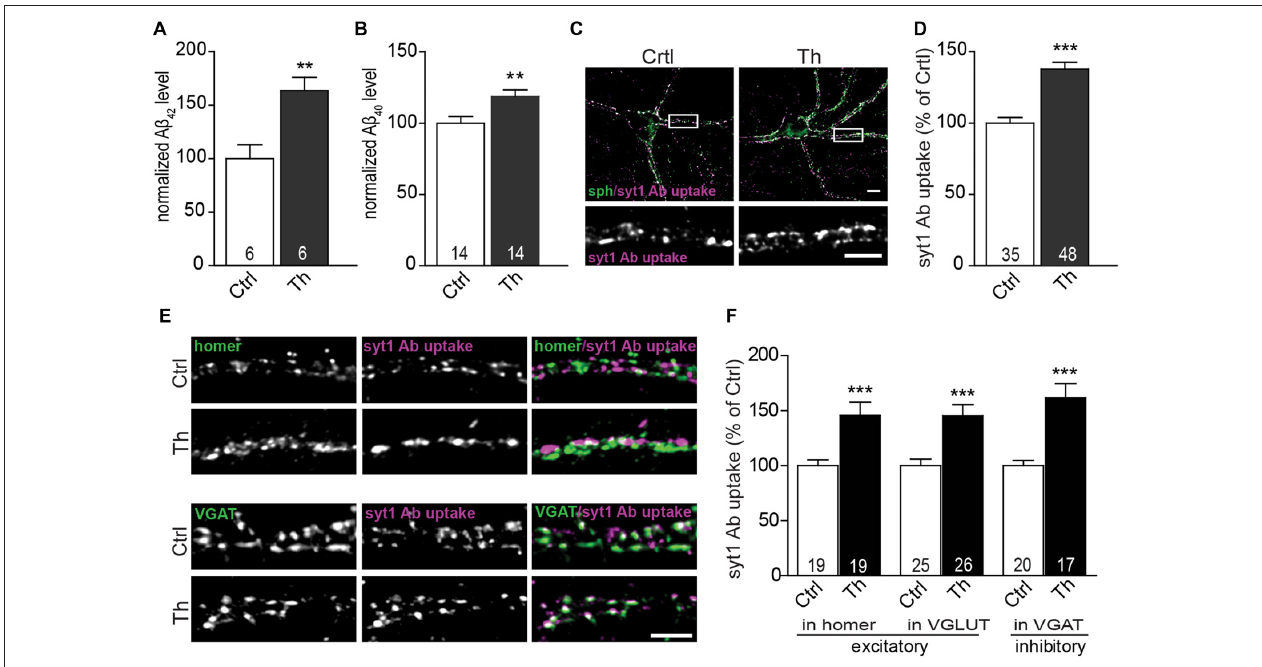
FIGURE 1 | Endogenous A β modulates presynaptic activity at excitatory and inhibitory synapses. (A,B) Quantification of A β x-42 (A) and A β x-40 (B) levels in the medium from vehicle- and Th-treated cortical cells using sandwich ELISA. Numbers within columns represent the number of individually treated and analyzed wells obtained from two (A) and three (B) independently prepared cell cultures. (C) Representative images of syt1 Ab uptake (magenta) from vehicle- and Th-treated cortical neurons. Synaptophysin (sph, green) was used as a synaptic marker. Regions showed in high magnification are boxed. (D) Quantification of normalized fluorescence intensity of network activity-driven syt1 Ab uptake in control and Th-treated neurons along proximal dendrites. (E) Representative images of syt1 Ab uptake, from cortical neurons incubated with Th or control solution, at excitatory (homer, green) and inhibitory (VGAT, green) terminals. (F) Statistical quantification of the intensity of syt1 Ab uptake in puncta positive for either excitatory (homer, VGLUT) or inhibitory (VGAT) synapses driven by the spontaneous network activity. Numbers within columns show the number of analyzed cells derived from five (D) and two (F) independent cultures. Values are expressed as the mean ± SEM. Effect of treatment was compared to untreated control by unpaired two-tailed Student t test ( A,B,D,F syt1 Ab uptake in VGLUT-positive and VGAT-positive) or Mann Whitney test ( F , syt1 Ab uptake in homer-positive puncta); ∗∗ p < 0.01, ∗∗∗ p < 0.001. Scale bars represent 10 µ m in overview and 5 µ m in